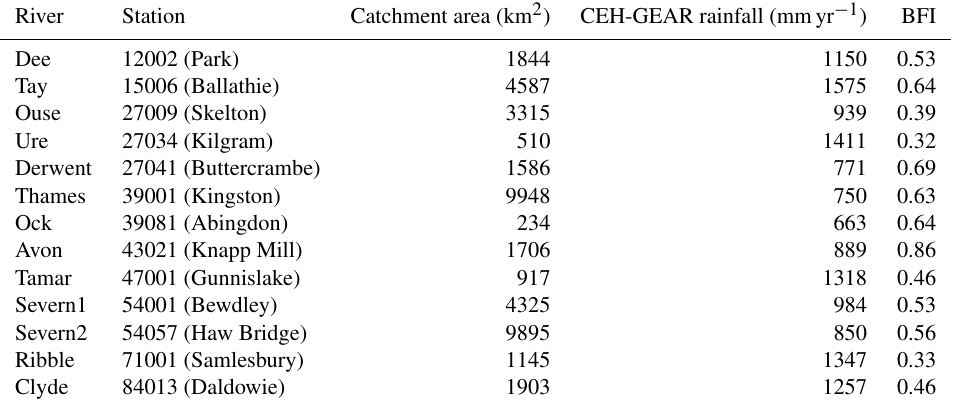
Table 1. Information about the selected catchments in Great Britain in Fig. 1. The outlet stations are identified by their National River Flow Archive (NRFA) station number and their name. The annual rainfall from the CEH-GEAR database refers to the studied period (1991–2000). The baseflow index (BFI) data were reported by Boorman et al.